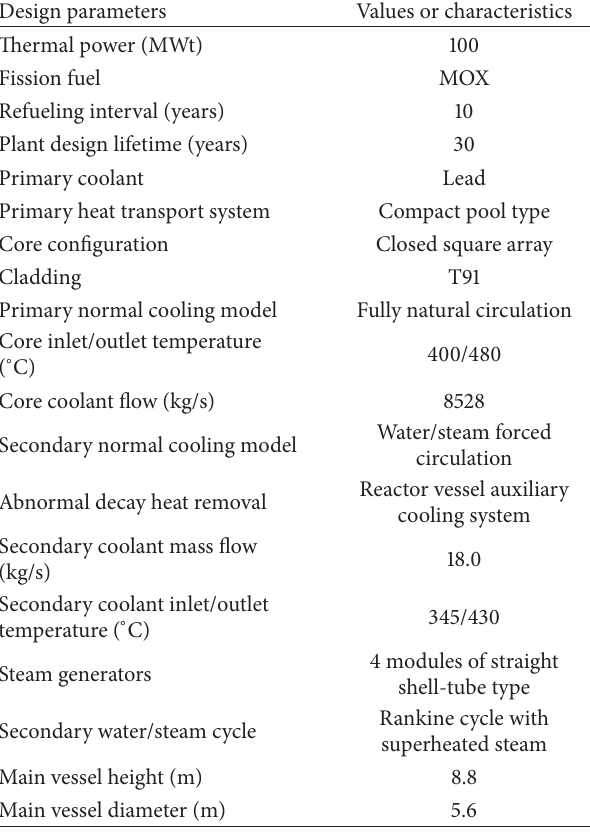
Table 1: Main design parameters of SNCLFR-100.